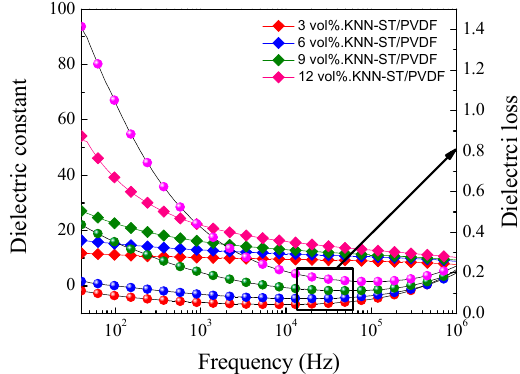
Figure 5. Dielectric constant and dielectric loss on frequency of KNN-ST/PVDF composite films. Table 1. Dielectric properties of pure PVDF, KNN/PVDF and KNN-ST/PVDF composite films.